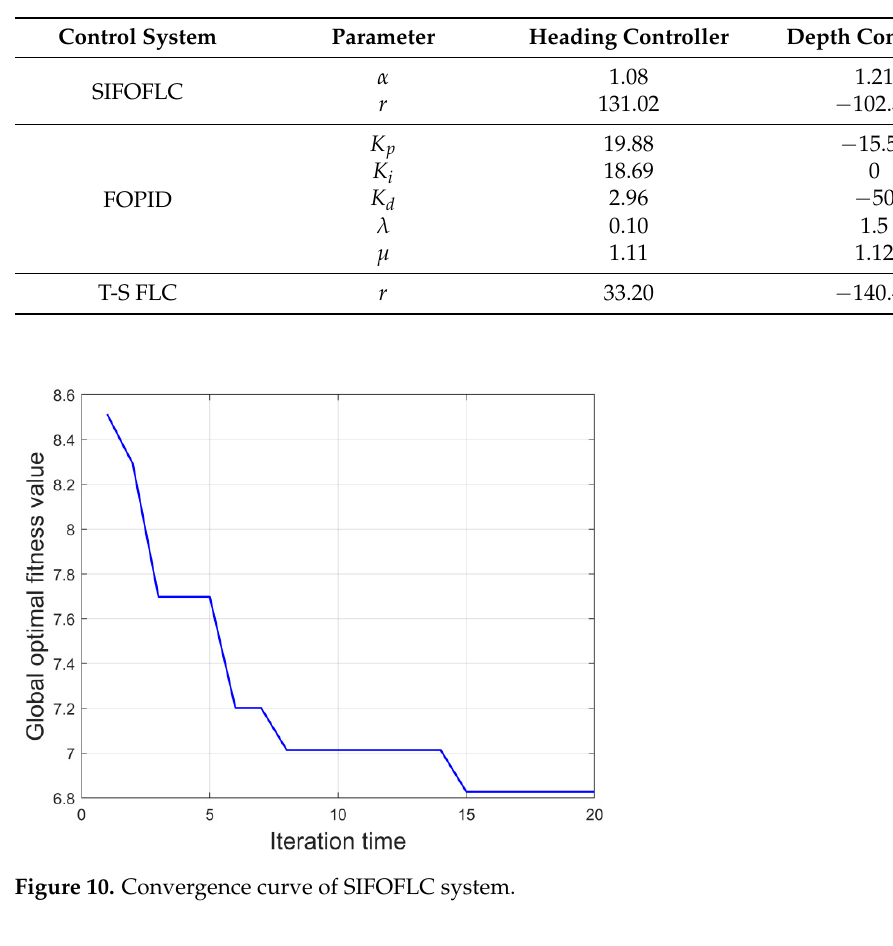
Table 3. Controller parameters optimized by HPSO algorithm.